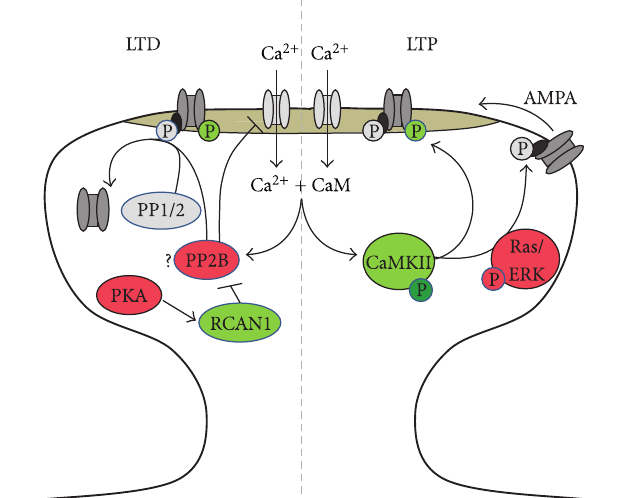
Figure 2: Alterations in intracellular signaling cascades a ff ecting postsynaptic AMPAR response in Ts65Dn hippocampus. Green indicates elevated levels/activity at baseline, while red indicated diminished activity. During LTP (right), enhanced CaMKII and GluR1 subunit phosphorylation in Ts65Dn synapses may result in a saturated condition incapable of additional potentiation. Reduced ERK activity may reduce migration of new AMPARs into the PSD. In LTD, overexpression of RCAN1 should reduce the activity of PP2B (calcineurin) resulting in reduced internalization of AMPA receptors and potential reduction of NMDAR mean open times. Rescue of LTD in Ts65Dn mice by NMDAR antagonists suggests enhanced NMDAR activity contributes to altered LTD through yet unidentified